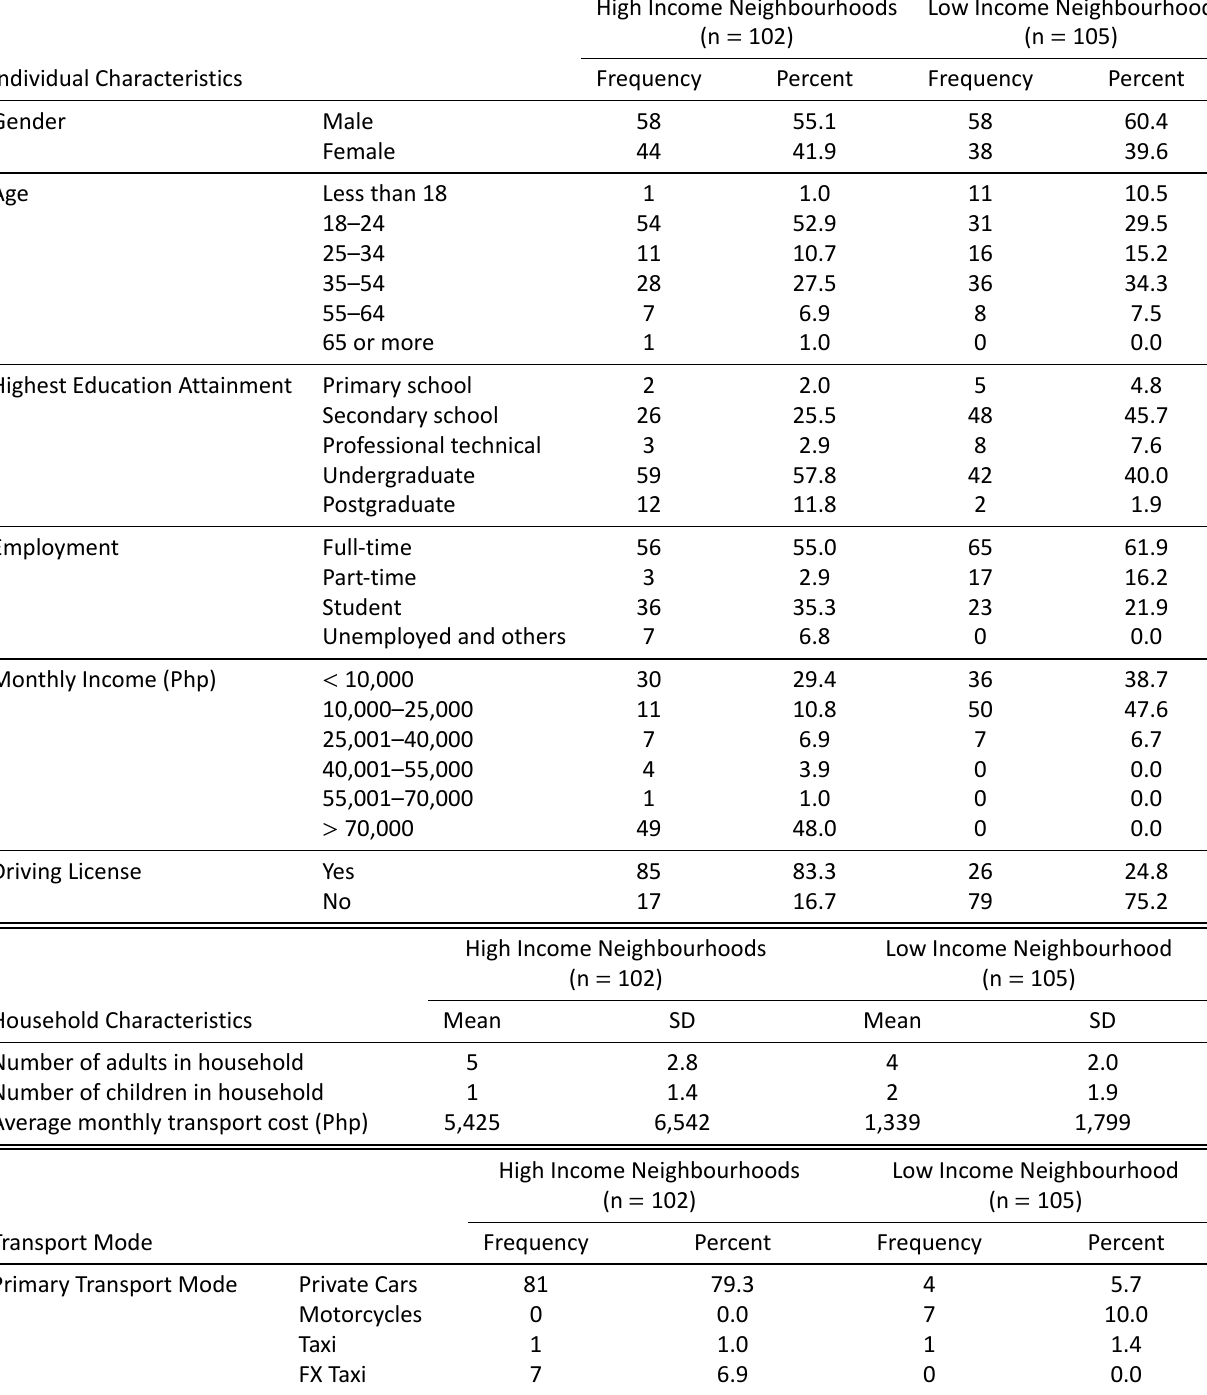
Table 1. Descriptive